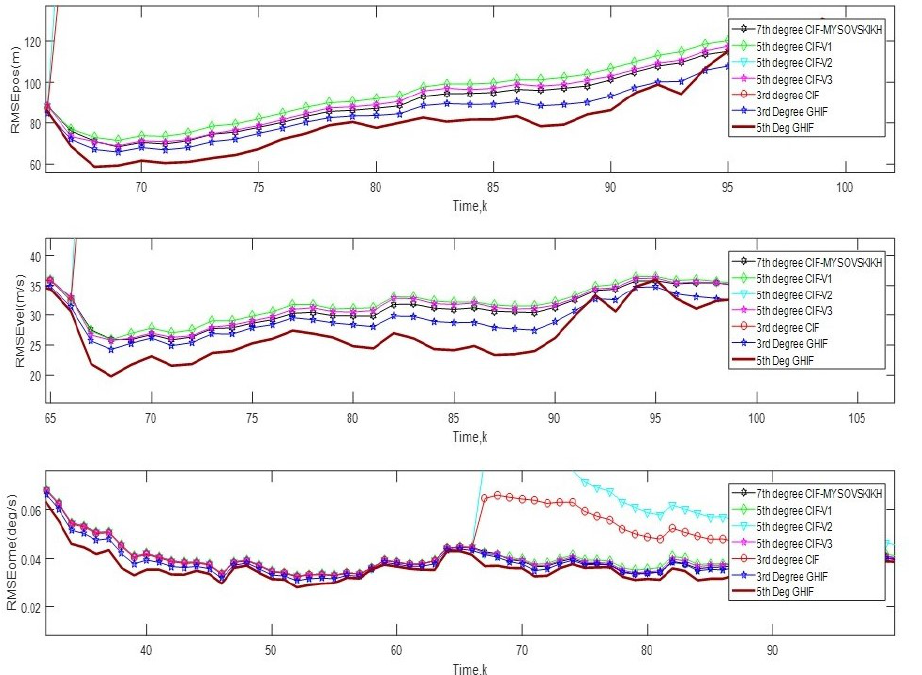
Figure 19. RMSE of GHIF 5th- and 3rd-degree approach based on TDOA/FDOA: In this figure, the lower error bound was achieved by GHQF 5th. It appears the RMSE convergence speed is perfect when using GHQF 5th degree based on hybrid TDOA/FDOA compared to conventional filters.